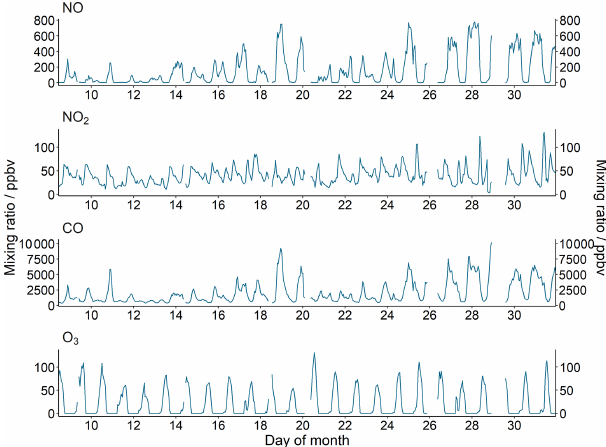
Figure 2. Observed mixing ratio time series of (from top to bottom): NO, NO 2 , CO, and O 3 during October